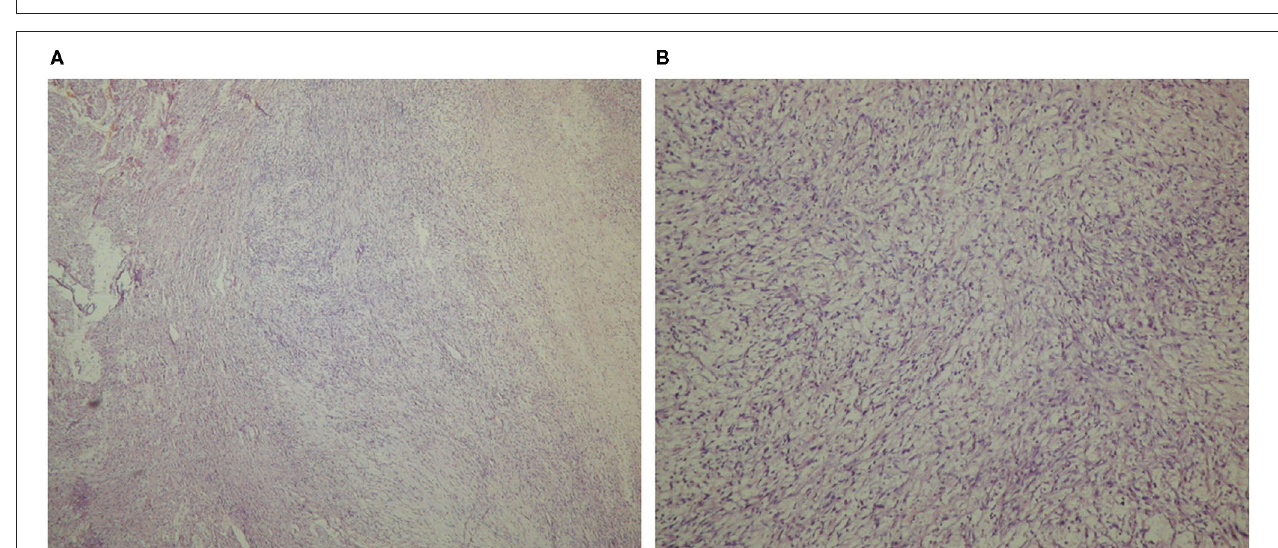
FIGURE 2 | Macroscopic appearance of the extirpated tumor formation.